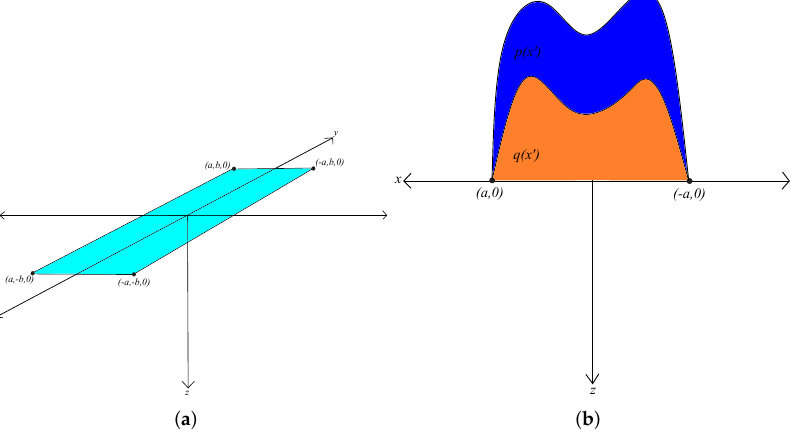
Figure 1. ( a ) Geometry of a three-dimensional Cartesian elastic half-space, with a loaded rectangular region of width 2 a and length 2 b , centered at the origin. ( b ) Geometry of the plane-strain problem, which results from taking the limit of the three-dimensional problem as b → ∞